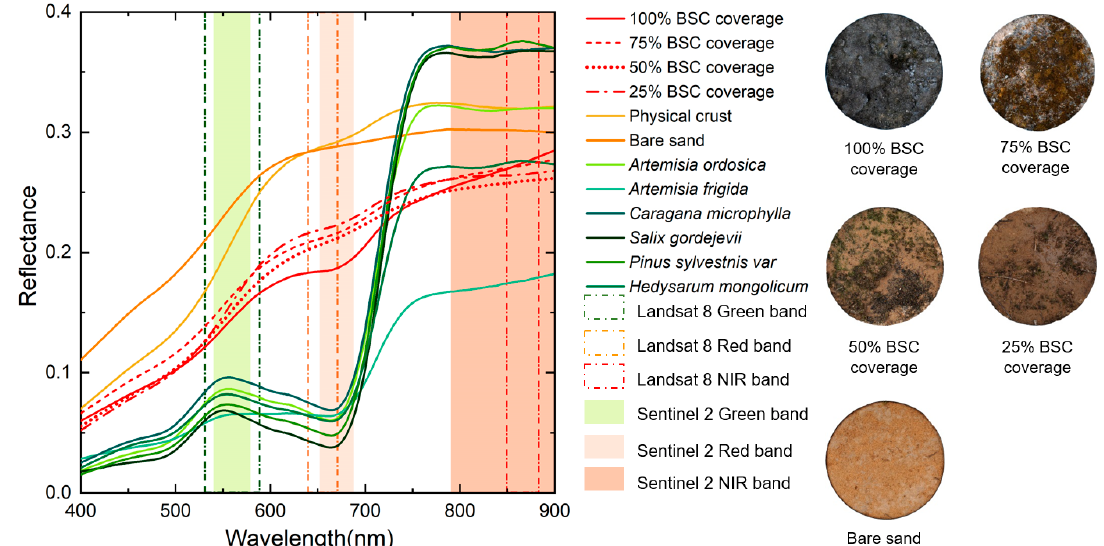
Figure 5. Reflectance spectra of different ground objects and different BSC coverage. Yellow lines are physical crust and bare sand. Green lines are vegetations. Red lines are different coverage of BSCs.